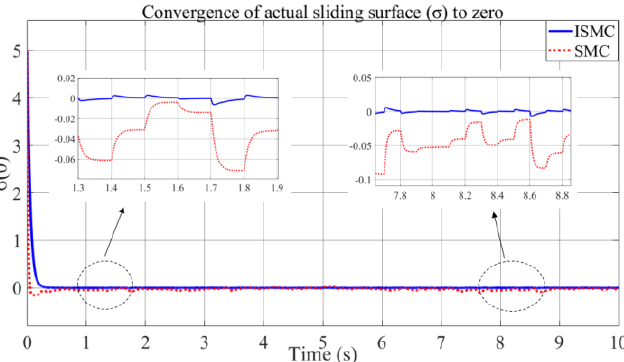
Figure 8. The actual sliding surface of both control schemes.